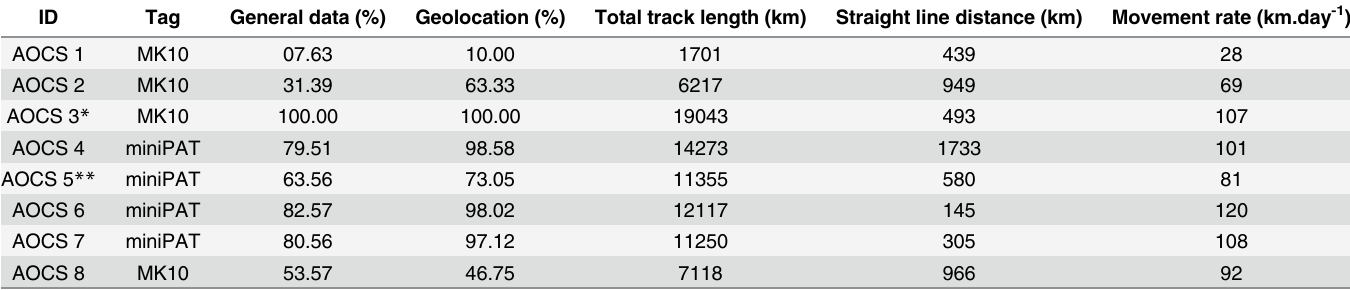
Table 2. Data reception of pop-up satellite archival tags and distances traveled by oceanic whitetip sharks tagged in the western Atlantic Ocean between 2010 and 2012.